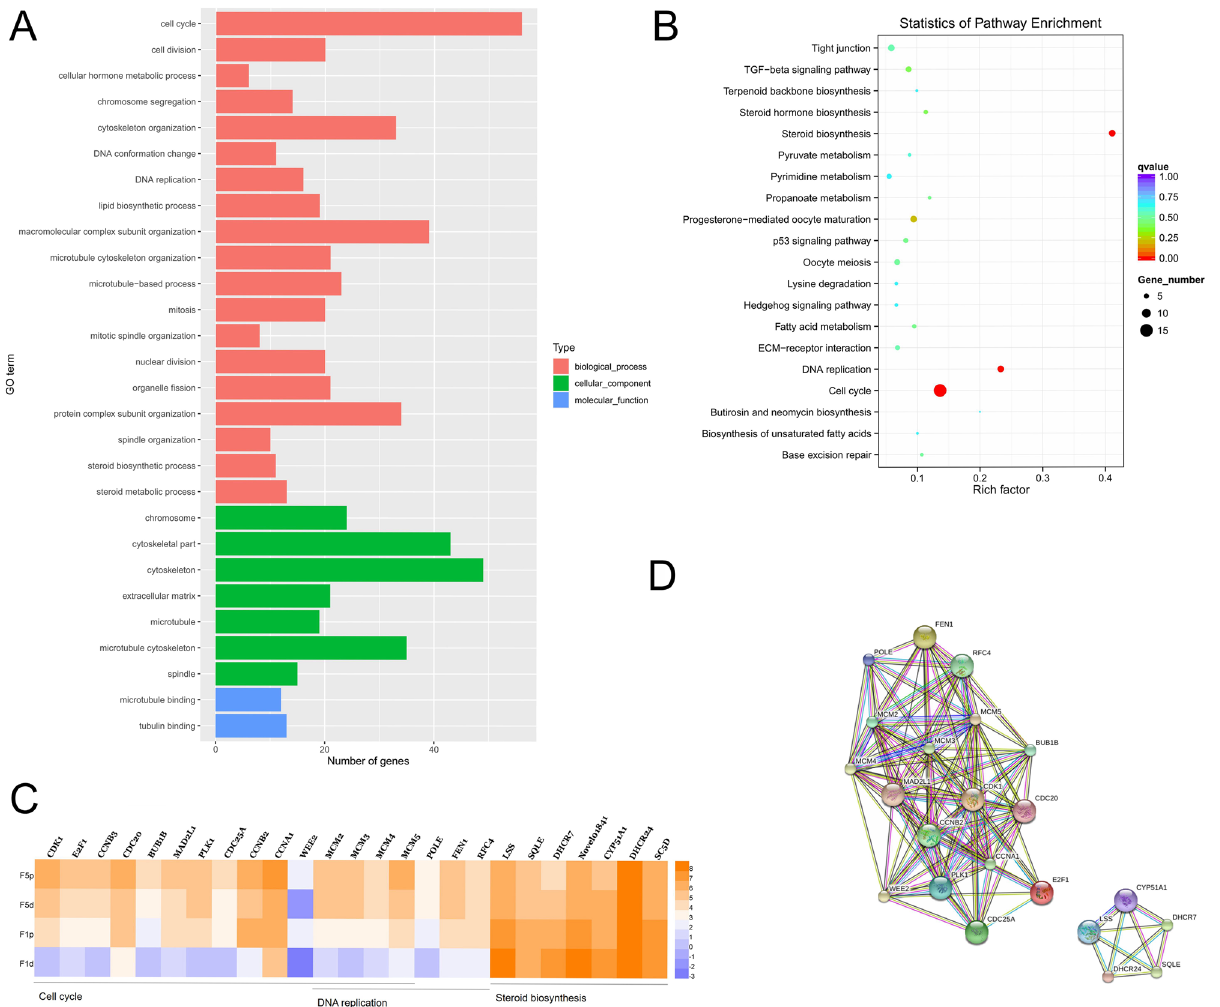
Figure 2. The differential gene expression profile of the granulosa cells (Gp and Gd) in F1 follicles. ( A ) Gene ontology (GO) functional enrichment of genes differentially expressed in the granulosa cells from F1 follicles. The y-axis and x-axis indicate the number of genes in each cluster and the names of clusters respectively. ( B ) Scatter plot of enriched KEGG pathways for differentially expressed genes in Gp and Gd granulosa cells from F1 follicles. The rich factor is the ratio of the differentially expressed gene number to the total gene number in a certain pathway. The size and color of the dots represent the gene number and the range of the q-value, respectively. ( C ) The heatmap displaying the genes enriched in cell cycle, DNA replication and steroid synthesis in KEGG analysis. The red colour represents the transcript over-expression or up-regulated while the yellow colour represents the transcript down-regulated. ( D ) The cell cycle, DNA replication and the steroid synthesis network identified from G1p and G1d granulosa cells based on STRING